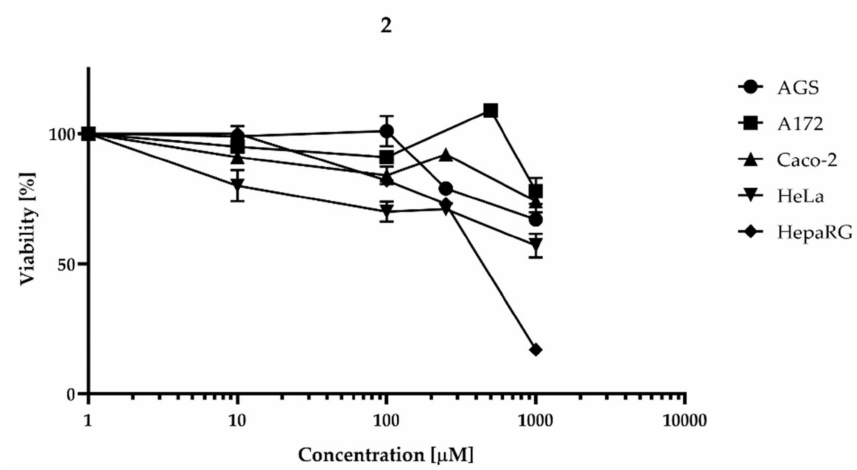
Figure 7. Viability changes after 72 h exposure to 2 . Concentrations applied to cells: 1000, 250, 100, and 10 µ M for Caco-2, A172, HepaRG, and HeLa; concentrations for AGS cell line: 1000, 500, 100, and 10 µ M. Concentrations were logarithmized, and viability was calculated as percentages.